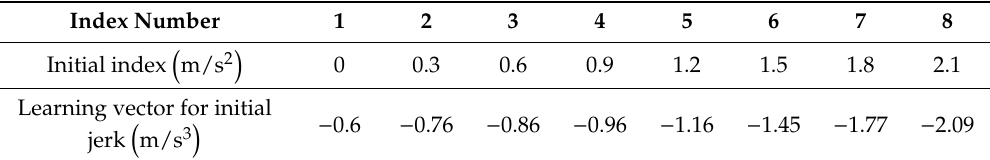
Figure 10. Gaussian distribution using value of initial index.